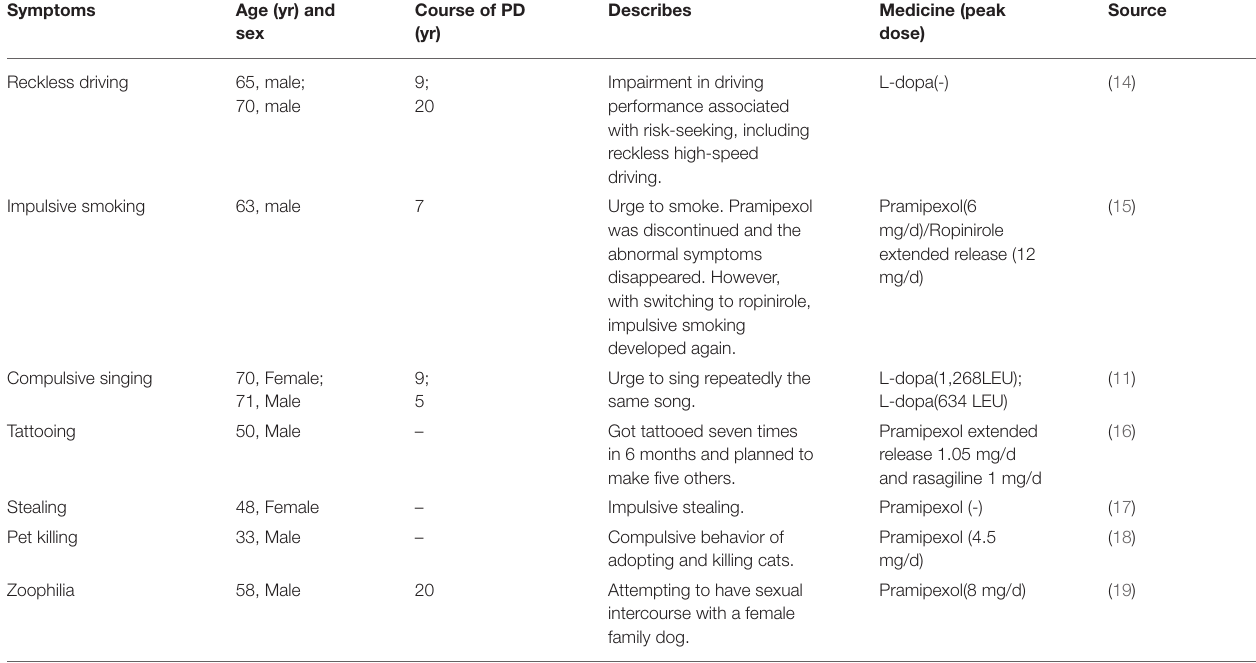
TABLE 1 | Rare ICD symptoms in Parkinson’s disease.